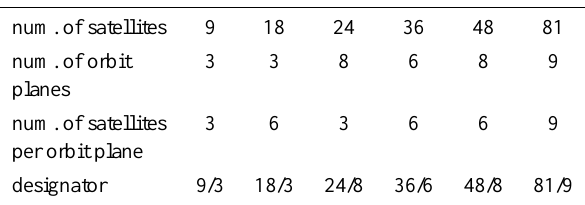
Table 3. Number of satellites and orbit planes for six GNSS-R Walker constellation